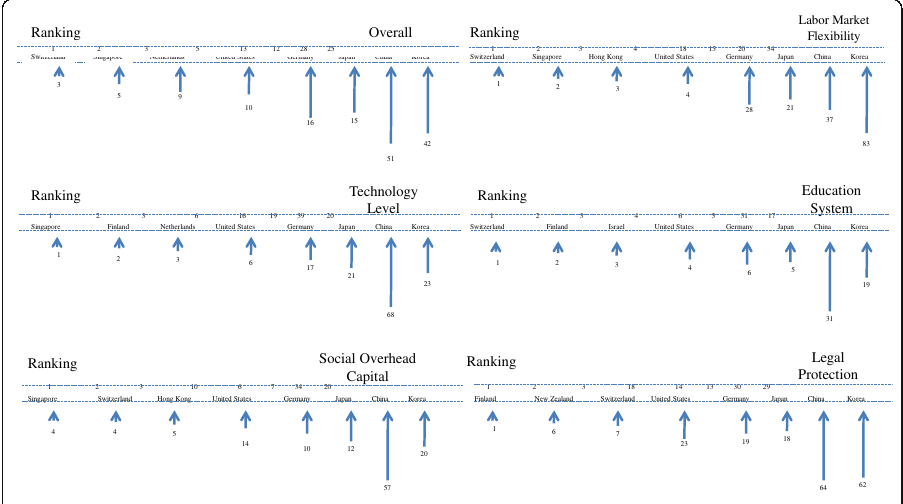
Fig. 2 Adaption Level of the Fourth Industrial Revolution